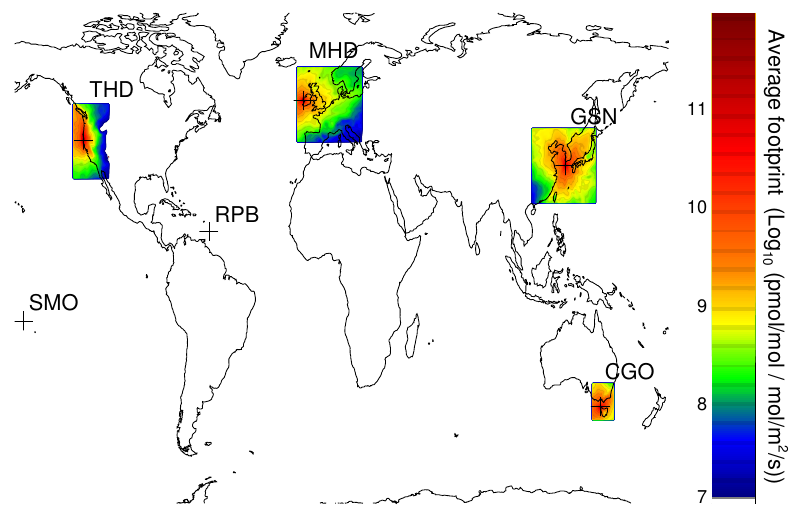
Fig. 4. Average footprints at four AGAGE sites (THD=Trinidad Head, California, MHD=Mace Head, Ireland, GSN=Gosan, South Korea, CGO=Cape Grim, Tasmania) for the year 2008. Also shown are the locations of two sites (RPB=Ragged Point, Barbados, SMO=Cape Matatula, Samoa) used to constrain background emissions. The boxes show the extent of the “local” regions in which the LPDM was used to estimate